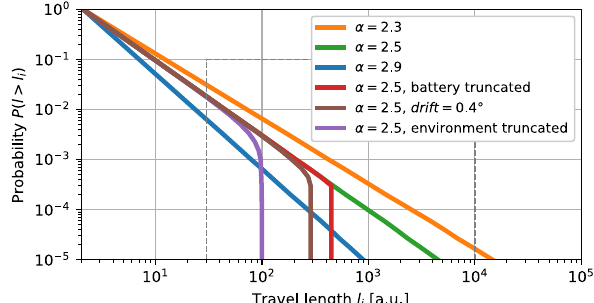
Figure 2. Modulation of Lévy travel length probability by intrinsic and extrinsic factors. Each represented trace is the complementary cumulative distribution function (CCDF) of the travel lengths for each strategy/parameter combination. We show its modulation by the exponent parameter α (blue, orange and green traces) and under different factors: intrinsic (battery truncated –red– and drift bound –brown–) and extrinsic (environment bound, 2 a basic model that truncates trajectories at 10 a.u. to represent search area diameter limit –purple trace–). Each CCDF was computed numerically with the models described in “Robot simulation models” section. The dashed rectangle indicates the region employed for the drift and battery analyses discussed in Fig.